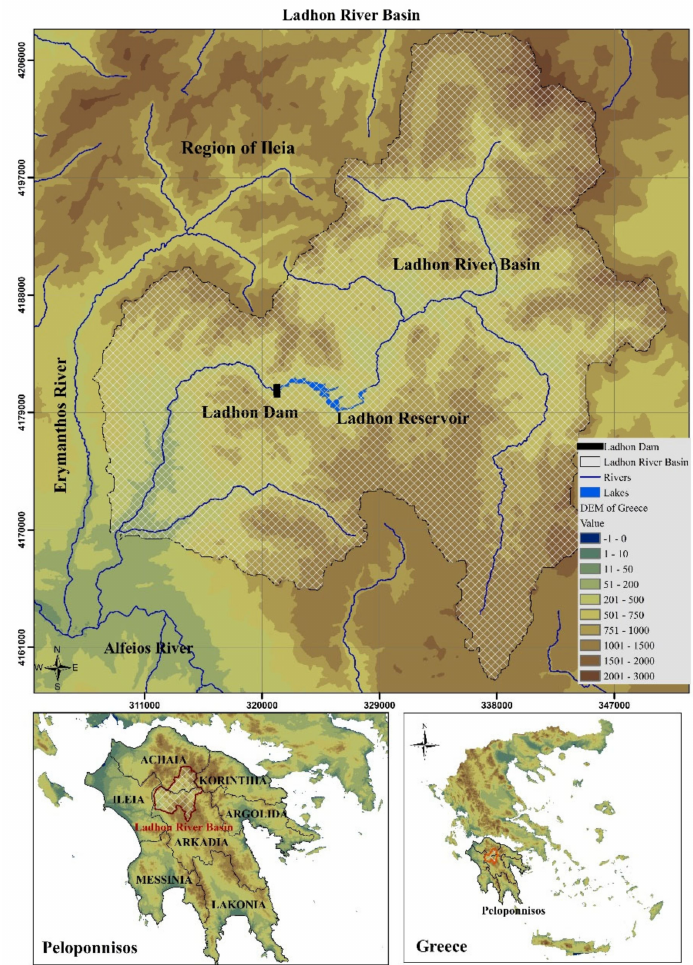
Figure 1. Ladhon River Basin and the wider Alfeios River area in Peloponnisos